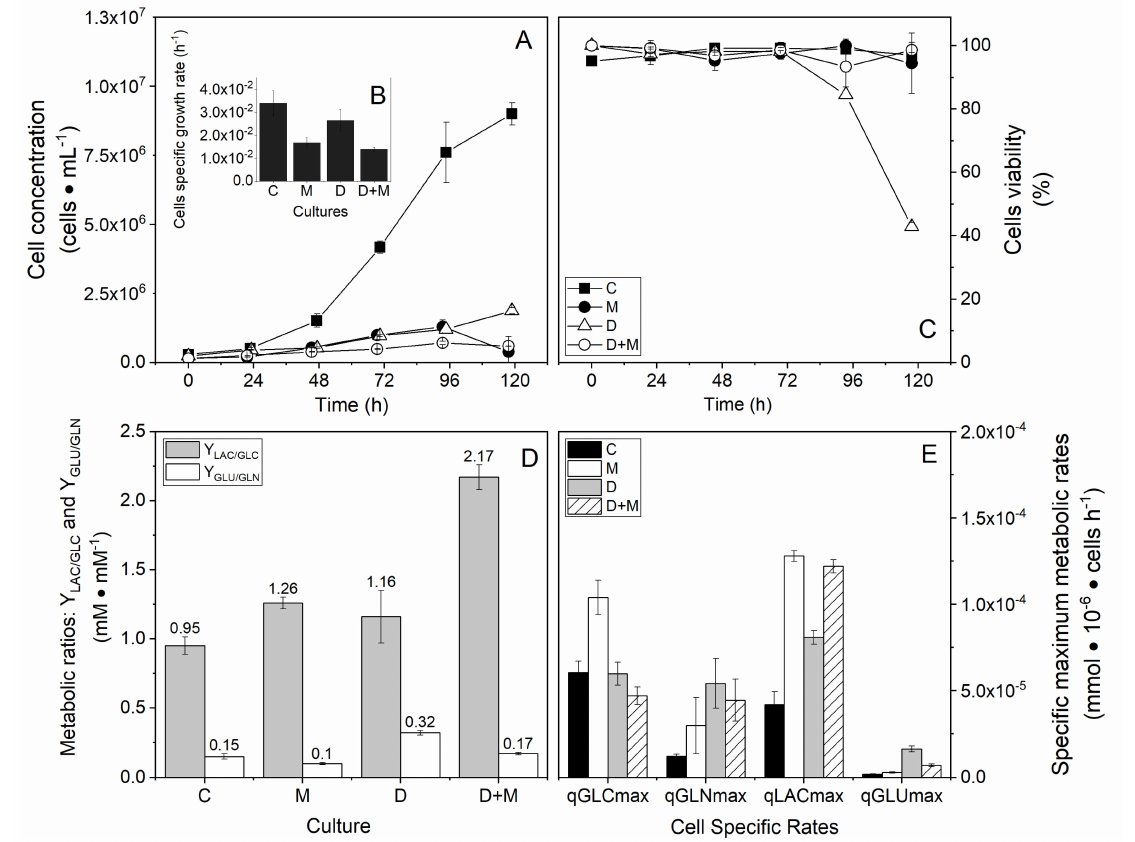
Figure 1. Effects of hyperosmotic culture conditions and drugs combinations on cell growth and metabolic phenotype. Experimental results for the shaken flask batch cultures for control conditions (filled squares, C), high osmolarity conditions induced with 200 mM D-mannitol (filled circles, M), control conditions with the addition of 8 µ M alpha-lipoic acid (ALA) and 300 µ M calcium hydroxycitrate (HCA) (empty triangles, D), and high osmolarity conditions with the addition of 8 µ M ALA and 300 µ M HCA (empty circles, D + M). ( A , B ) Batch cell concentration and cell growth rate were determined. Cell growth rates were calculated from the maximum growth rate phase in each condition. Cell growths were highly inhibited under the high osmolarity condition and/or with the drugs combinations compared to the control condition. This is highlighted by the cell-specific growth rate, which was higher in the control condition. ( C ) Viable cell density. Cell viabilities were flat and quite similar for all conditions, except for the drugs combination condition where cell viability fell suddenly after 70 h of culture and reached 43% at the end of the culture. ( D ) Metabolic ratios of lactate per mole of glucose consumed (Y LAC/GLC , grey bars) and glutamate per mole of glutamine consumed (Y GLU/GLN , grey bars) were set. Lactate yield was higher in the D, M, and D + M conditions compared to control. Glutamate yield was higher in the D condition but relatively close to control for the M and D + M culture conditions. ( E ) Specific maximum metabolic rates for each metabolite. Glucose consumption rate was higher under high osmolarity. Glutamine consumption was higher in drugs and/or mannitol compared to control. The same was true for the lactate production rate, which was found to be much more pronounced in drugs and/or mannitol. Glutamate production rate was higher in the D and D + M conditions, which are markers of reduced glutaminolytic